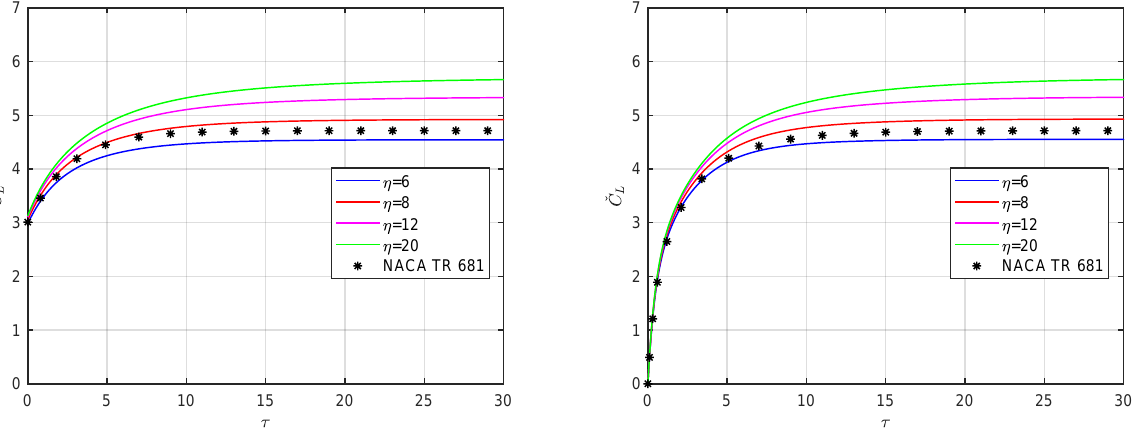
Figure 1. The indicial circulatory lift for elliptical thin wing in incompressible flow: AOA ( left ) and SEG ( right